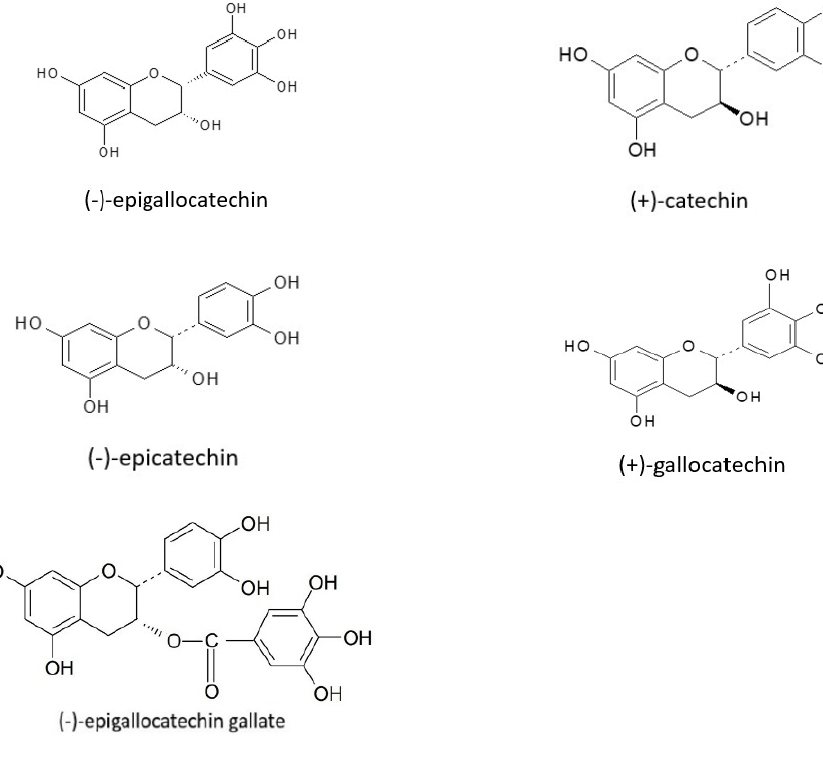
Figure 2. Structural formulas of selected flavan-3-ols.